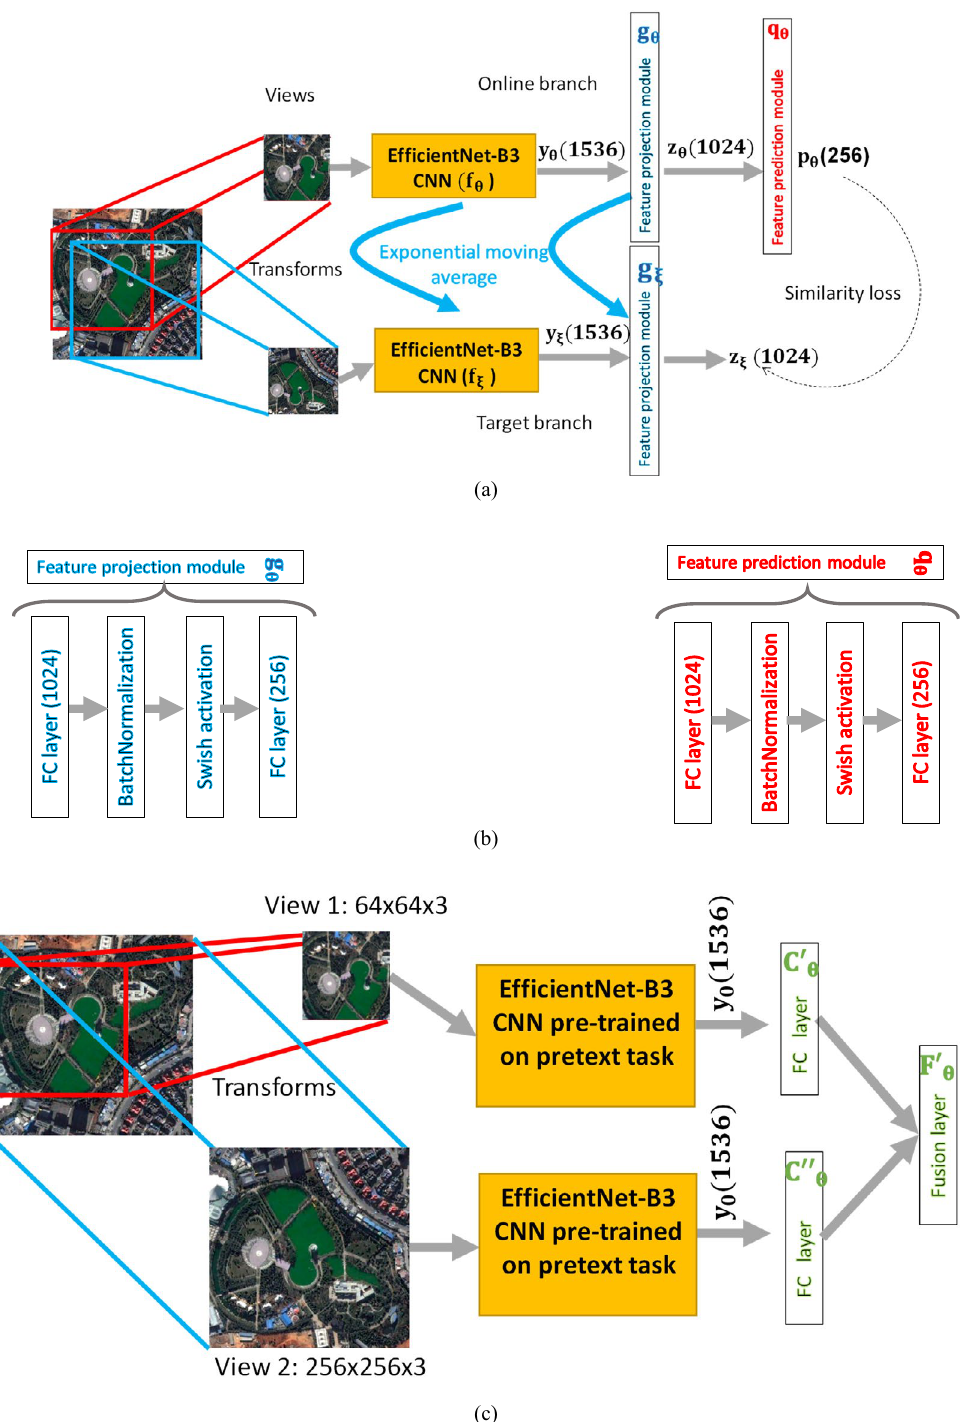
Figure 2. Architecture of the RS-FewShotSSL method for RS scene classification. ( a ) the architecture used for the pretext task, ( b ) the details of the projection and prediction layers, and ( c ) the architecture used for the downstream